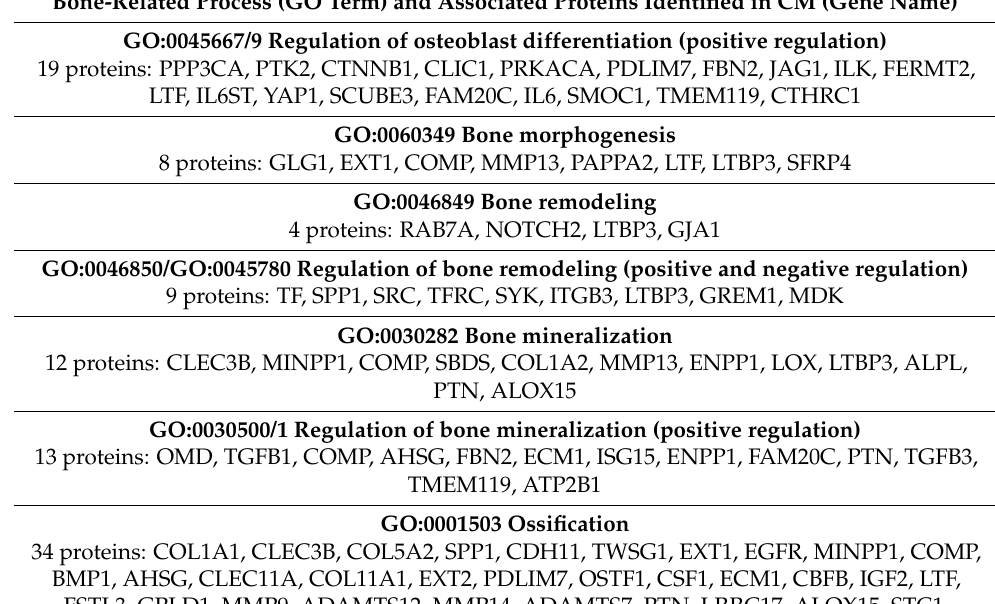
Table 1. Cont. Bone-Related Process (GO Term) and Associated Proteins Identified in CM (Gene Name) GO:0045667/9 Regulation of osteoblast differentiation (positive